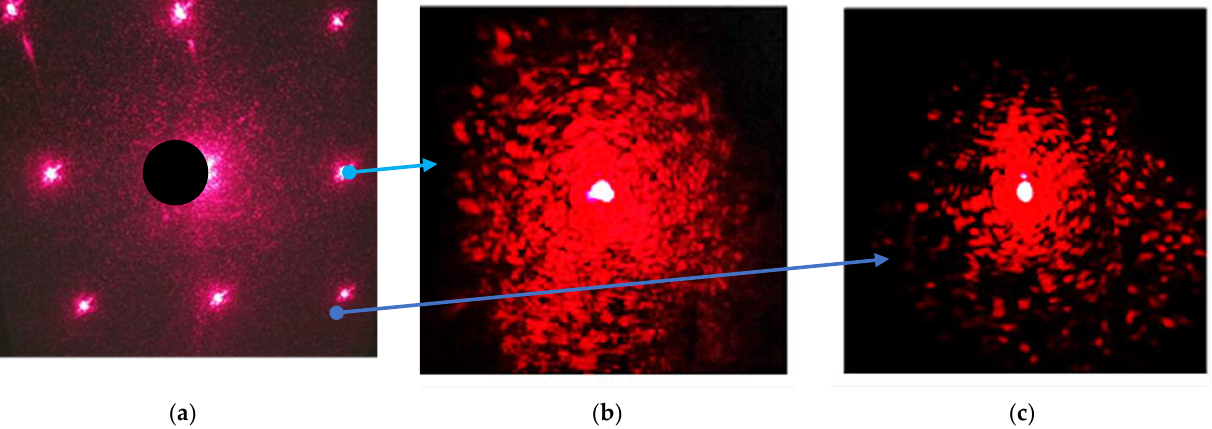
Figure 12. Speckle fields generated by E. coli M-17 suspension No. 2 loaded in microvials of multichannel planar chip with 8 vials after 10 min of observation ( a ); speckle fields generated by the suspension of E. coli without an antibiotic ( b ); and the same as b with ceftriaxone, 20 mg/mL ( c ). Arrows show the enlarged images of the corresponding cells.